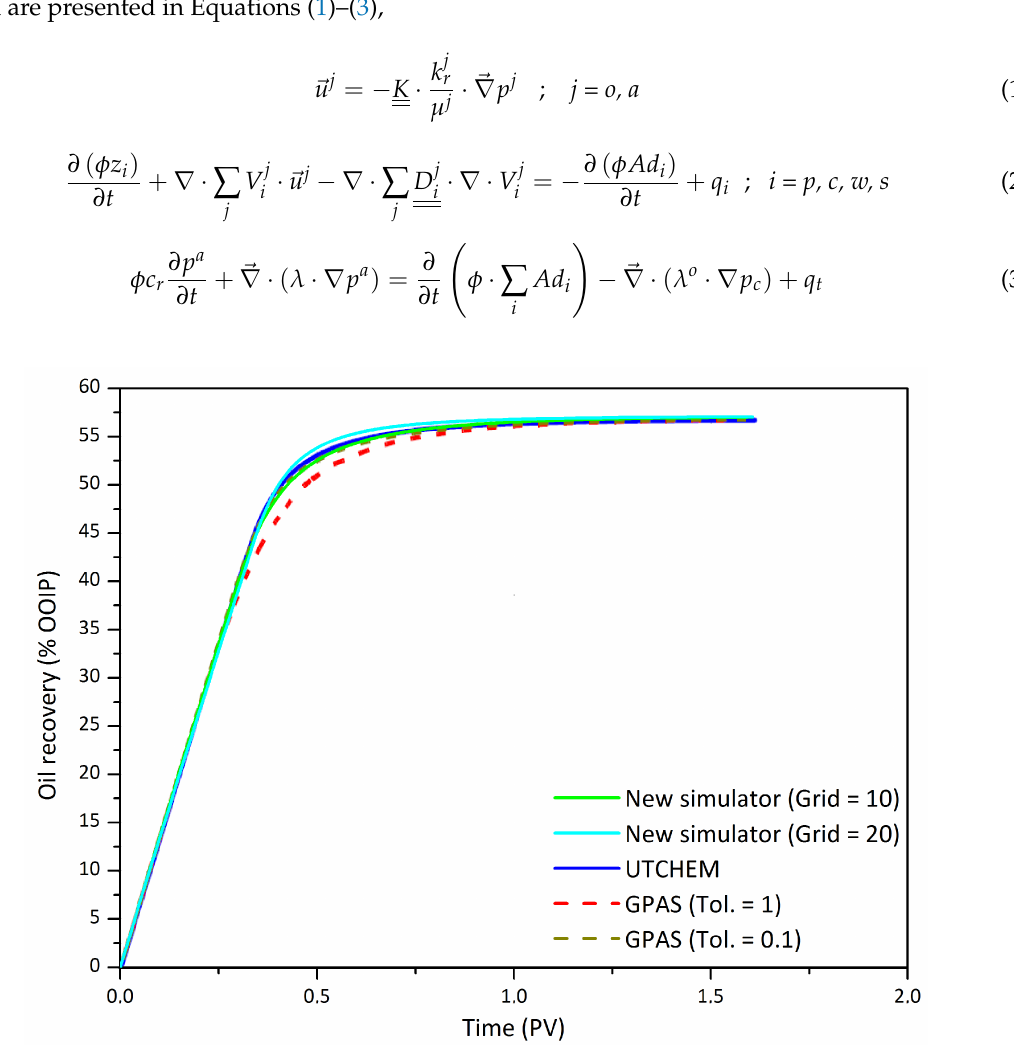
Figure 2. Oil recovery during a waterflooding, comparing the results with UTCHEM and GPAS